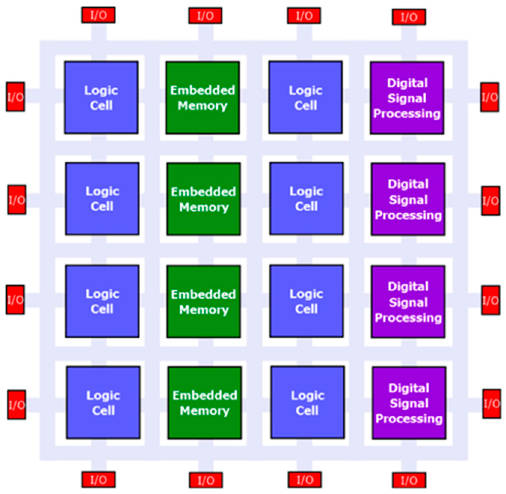
Figure 10. Simplified block diagram of a FPGA architecture.